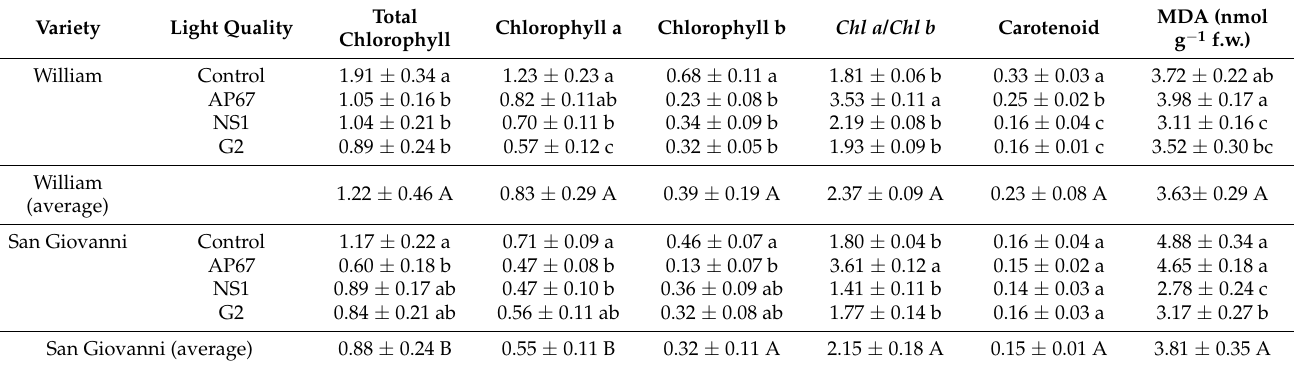
Table 3. Total chlorophyll, chlorophyll a, chlorophyll b and carotenoids (mg g − 1 ), chl a and chl b ratio, total protein (mg g − 1 f.w.) and MDA ( µ g g − 1 f.w.) in William and San Giovanni shoots grown under different LED light conditions (AP67, G2 and NS1) and Fluorescent Lamps (Control). Data are represented as mean ± SD. Different lowercase letters on the columns for both varieties indicate significant differences among light treatments (Duncan’s test, p < 0.05). Different capital letters on the columns indicate significant differences among varieties ( t